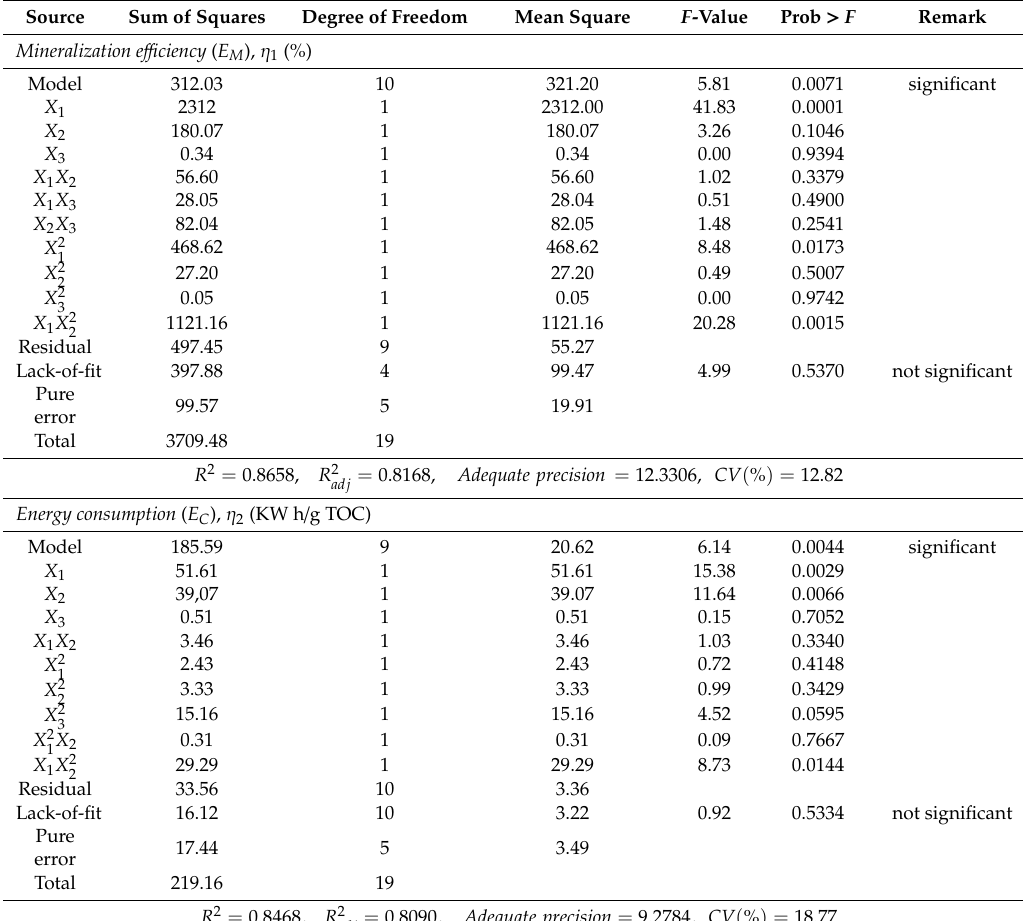
Figure 3. ( a ) Perturbation graphic for 1 and ( b ) Perturbation graphic for 2 .